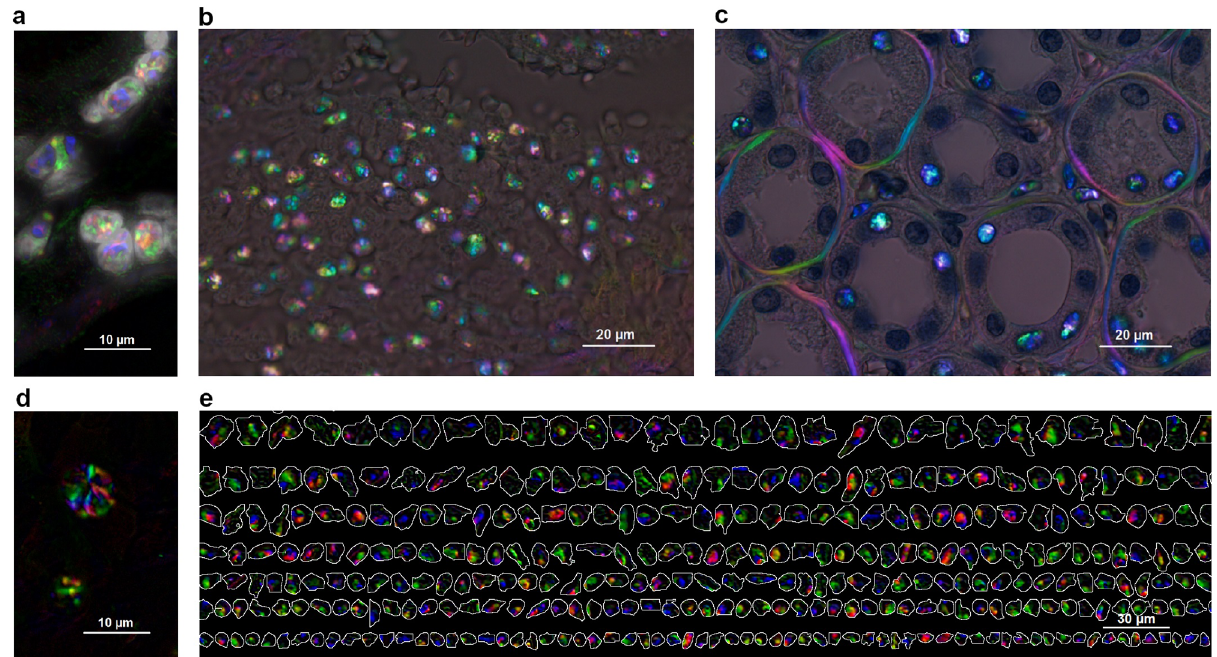
Figure 1. Spatial patterns of IBI captured by PPM. ( a ) Extracted PPM signals of intranuclear inclusions overlaid with Hoechst-stained fluorescence image for nuclei visualization; ( b ) endometrioid carcinoma tissue section by PPM after deparaffinization showing a cluster of IBI; ( c ) IBI and basement membrane collagen PPM signals in kidney tissue section stained with hematoxylin for nuclei visualization and imaged using PPM; ( d ) Crystalloid structure of the IBI—nuclear inclusions captured in FFPE unstained tissue sections imaged by PPM with digital background correction; ( e ) gallery of nuclei segmented from Hoechst-stained renal cell carcinoma tissue imaged by fluorescence and overlaid with IBI acquired by PPM. All images acquired with Olympus BX63 microscope equipped with an Olympus DP80 camera using the CellSens acquisition software. Objectives: ( b , c ) Olympus UPlanApo 100x , ( a , d ) additional ×2 magnification lens used, ( e ) Olympus LUCPlanFLN 20x , with Olympus U_FUNA DAPI fluorescence filter cube. Original images acquired at a resolution of 1360 × 1024 px, resized and put into multi-panel figure using the GIMP image